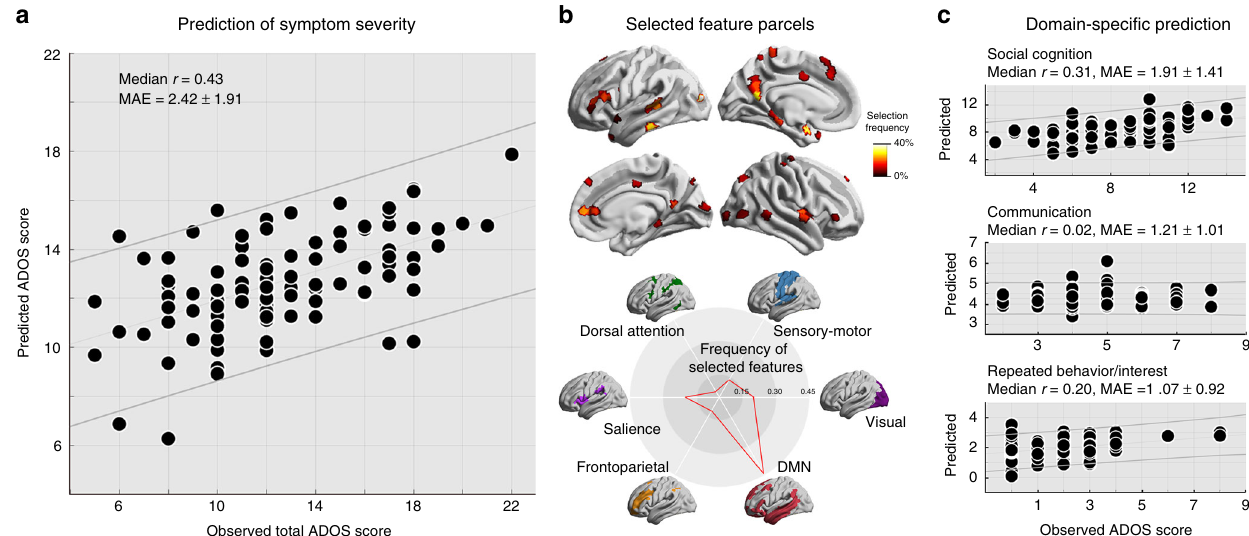
Fig. 5 Relation to ASD symptom severity. a A supervised learning algorithm with 5-fold cross-validation was trained on gradient and SFC features to predict total ADOS scores and subscores in individuals with ASD. Signi fi cant accuracy was achieved for total ADOS scale ( shown ) and subscales for social cognition and repetitive behavior/interest (permutation-tests; p < 0.05). b Selected features across 100 iterations of the cross-validation, showing frequently selected features in hot colors. Community-based strati fi cation 18 illustrates that most features were selected in visual, salience, and the DMN. c Prediction of subdomains (i.e., social cognition, communication, repetitive